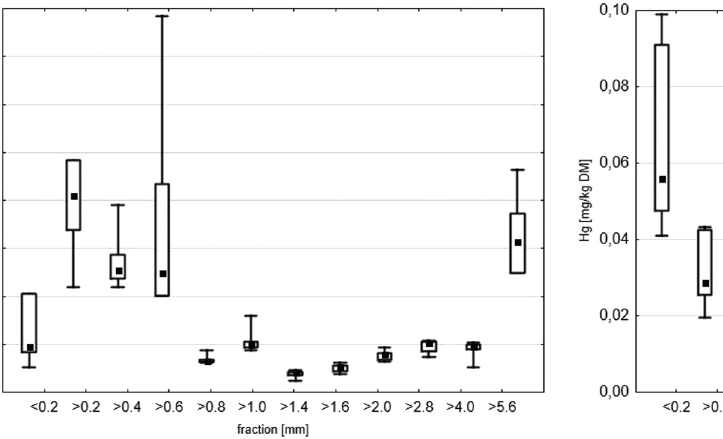
Figure 4: Box and whisker plots of LFW fractions ( % ) . The edges of the boxes show the SD, the whiskers show min – max, respectively. The mean is marked with a square point.